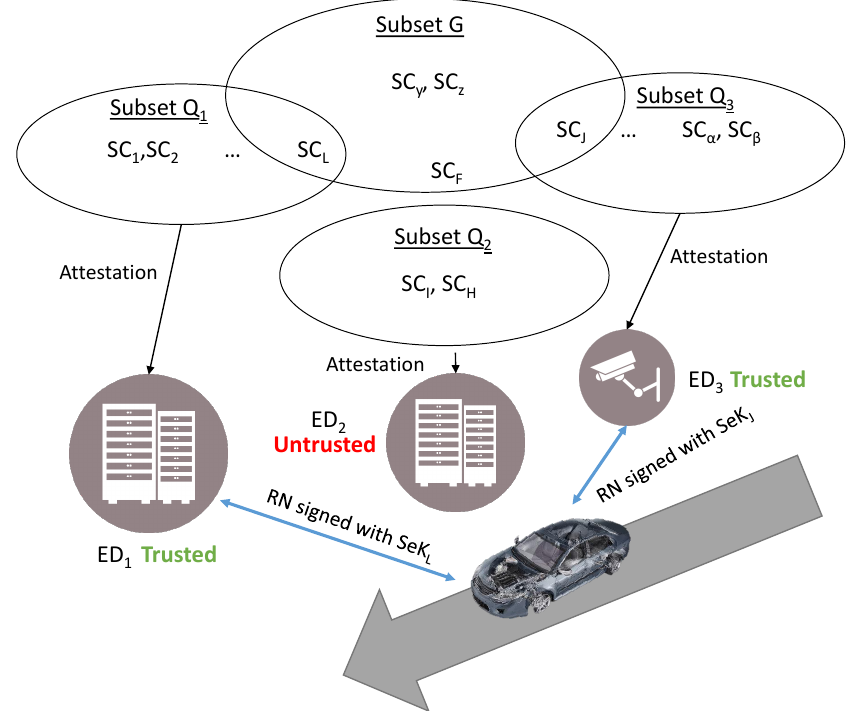
Figure 6. Visualization of edge computing as trusted service. A car reaching a location needs the local services of several edge and IoT devices. All these devices have many SeKs available validated by an SC each. The car just trusts in some of the SCs, those which belong to subset